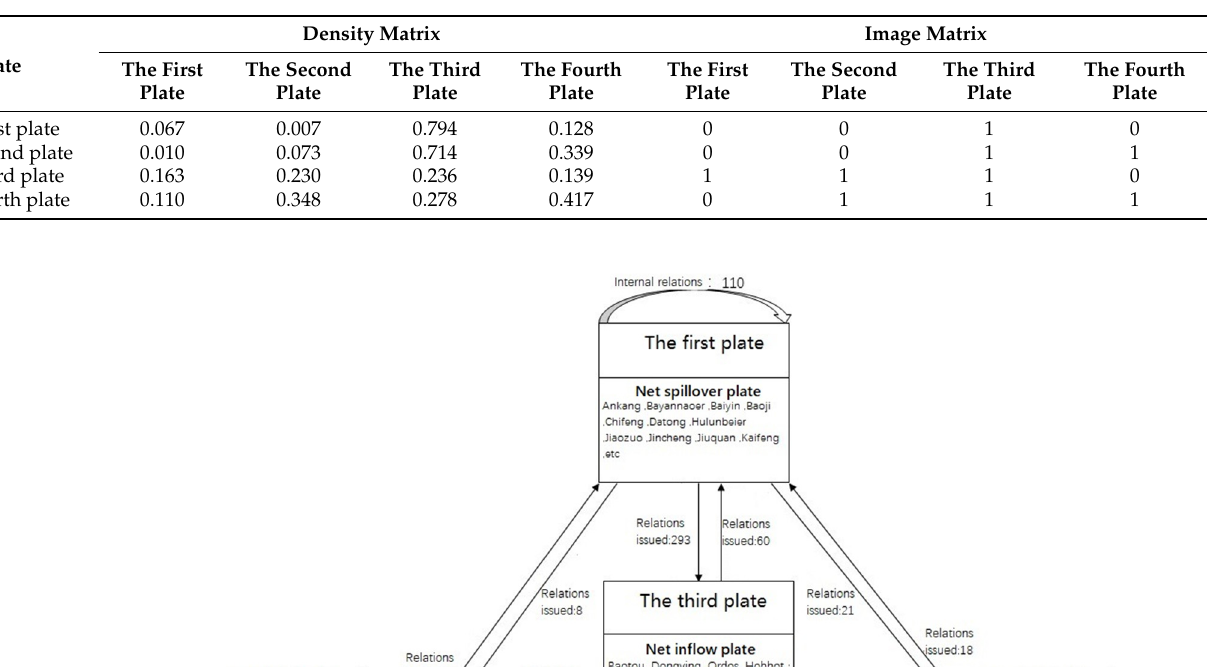
Table 5. Density matrix and image matrix table.